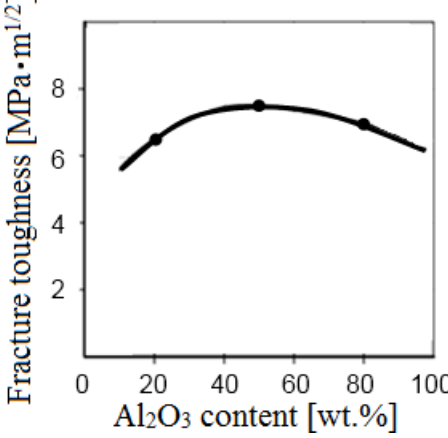
O -WC sintered materials (50/50 wt %) 2 3